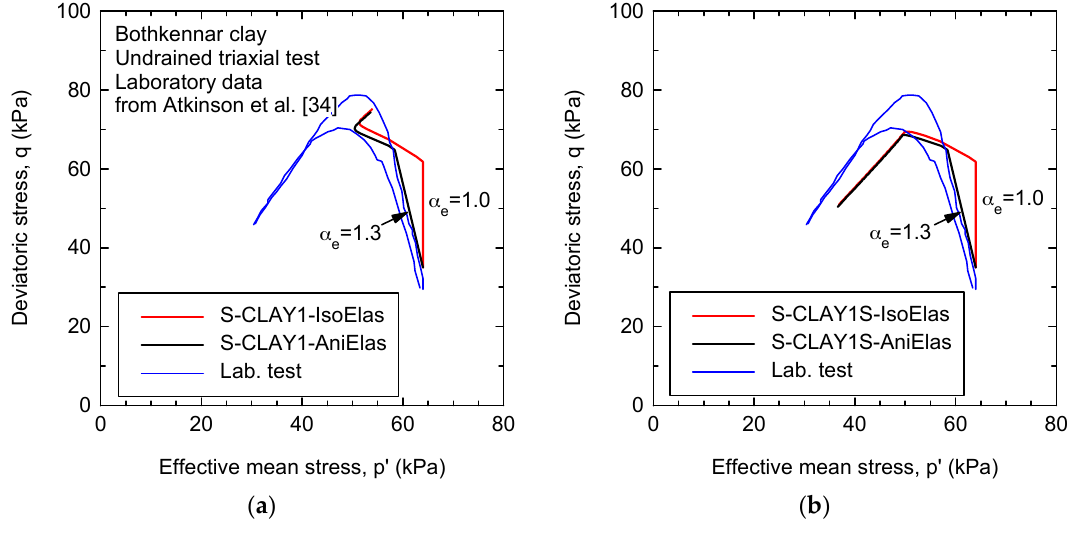
Figure 6. Effective stress path for undrained triaxial compression: ( a ) simulations using S-CLAY1; and ( b ) simulations using S-CLAY1S (considering destructuration).